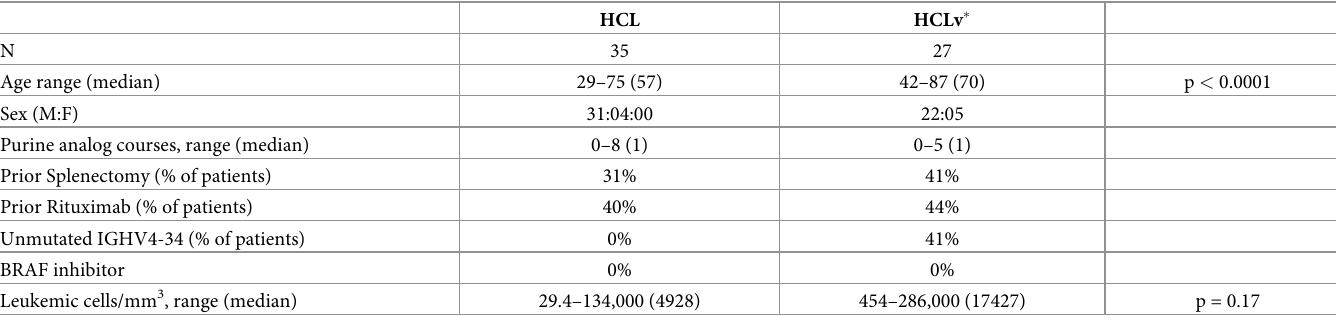
Table 1. Patients tested in microarray